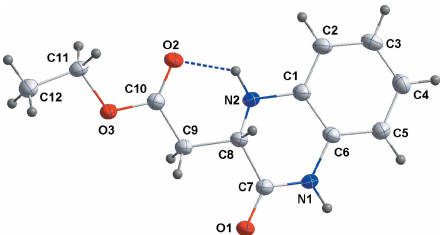
Figure 1 The title molecule with labeling scheme and 50% probability ellipsoids. The intramolecular hydrogen bond is depicted by a dashed line. Only the major component of the disorder is shown.